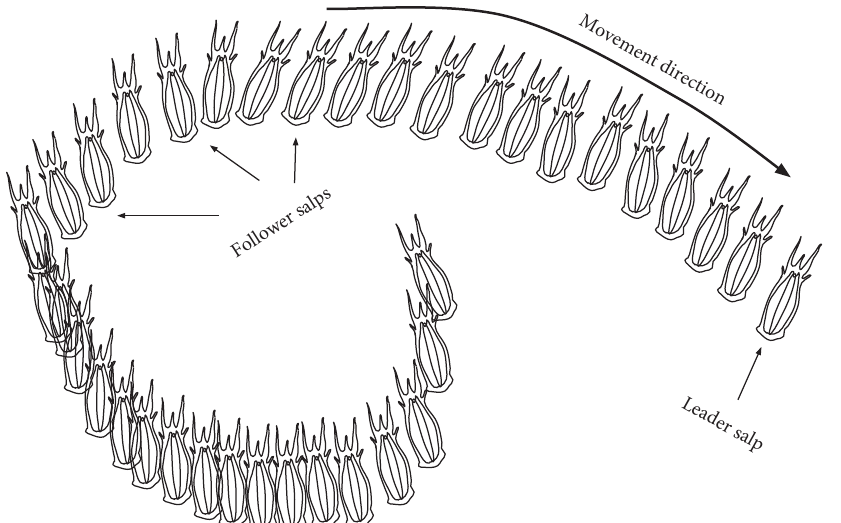
Figure 1: Leaders and followers of salps chain movement.